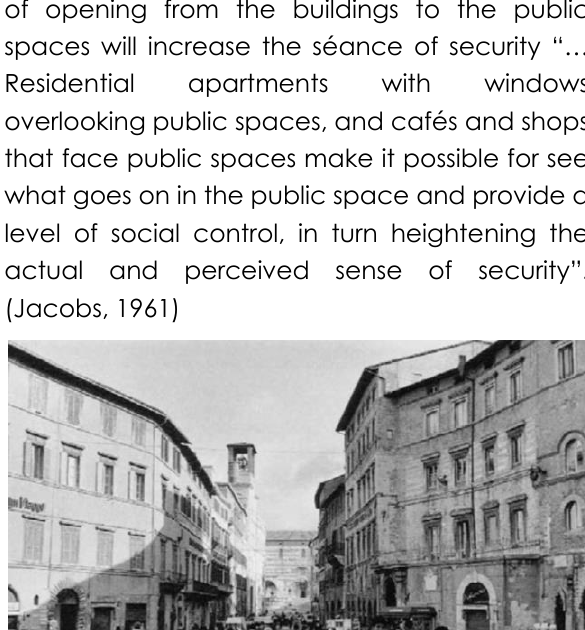
Figure 8. Vitality as one of the main factors shaping special quality.